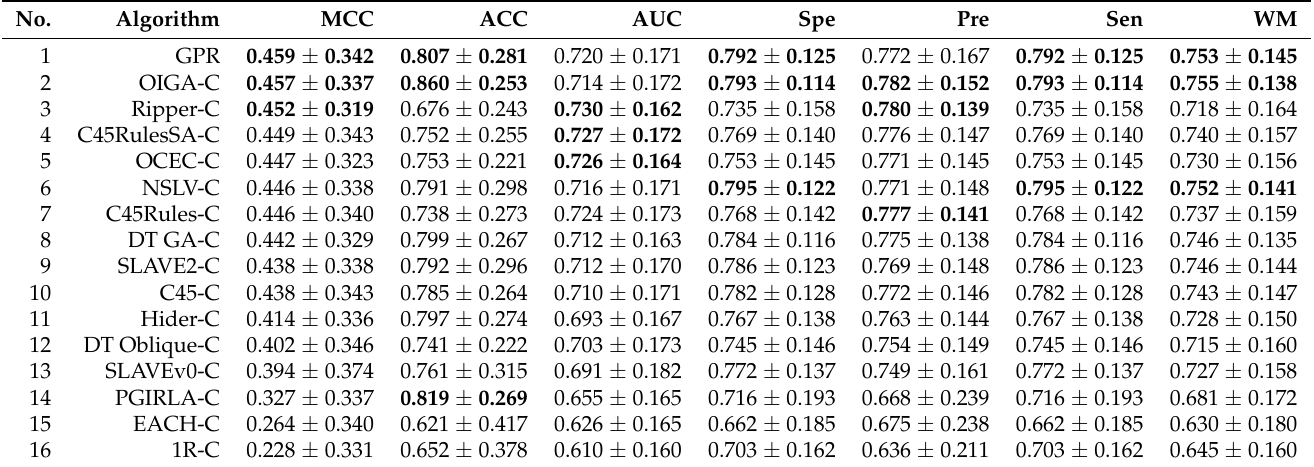
Table 2. Results of a comparison of fuzzy rule-based